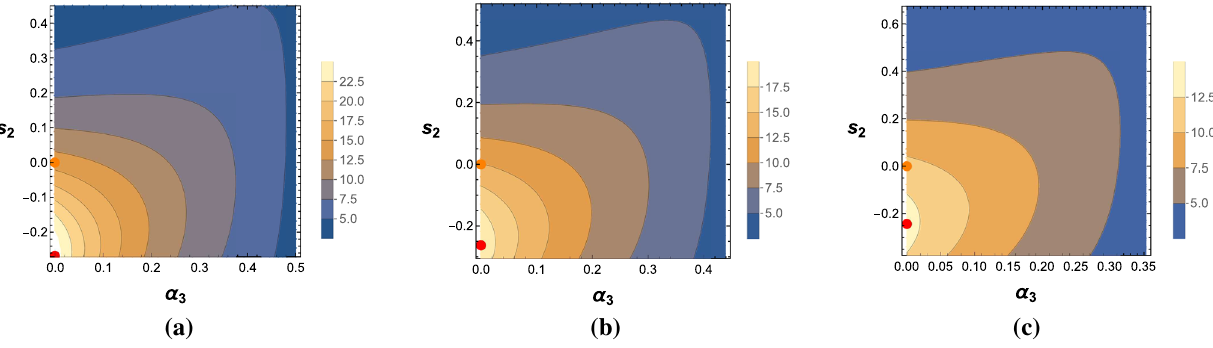
Fig. 5 The contour maps of O in terms of α 3 and s 2 for different val- ues of n . The maximum value of O for the spinning case is marked at the red point, and the non-spinning case is marked at the orange point ( α 3 = 0 , s 2 = 0). a When n = 0, for the spinning case, η = O ≈ 26 . 8564 with s ≈ − 0 . 2679; for the non-spinning max max 2